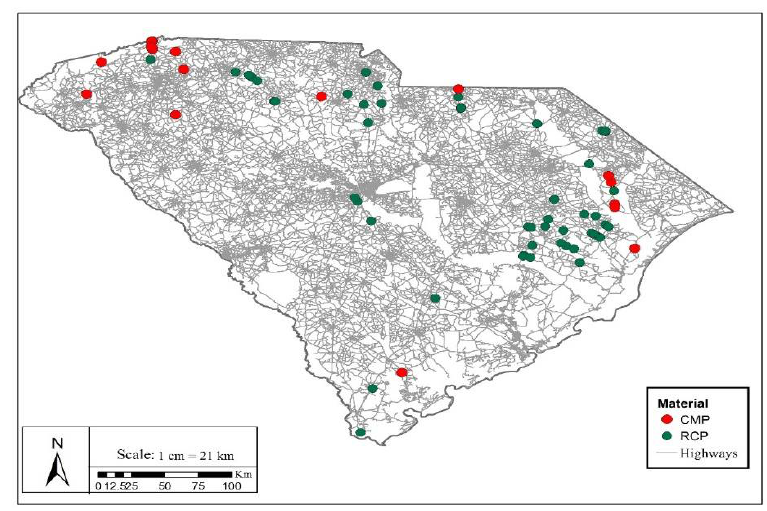
Figure 7. A map showing the at-risk RCP and CMP culverts from the inventoried database.